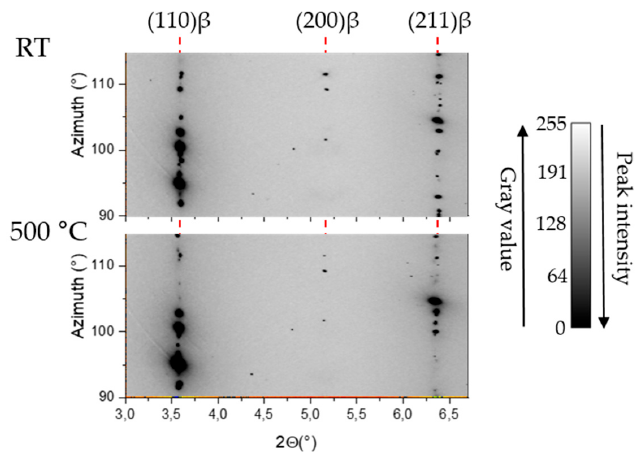
Figure 2. 2D plots of portions of Debye–Scherrer rings converted into Cartesian coordinates showing the behavior of spots corresponding to Bragg reflections for RT and 500